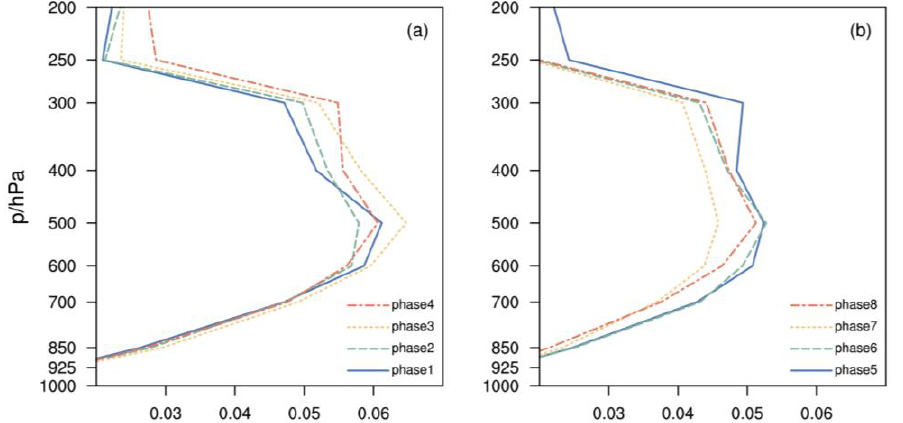
Figure 4. Vertical distribution of apparent heat source Q 1 (units: W/kg) in the ( a ) heating phase and ( b ) cooling phase in the Indo-China Peninsula (8° – 23° N, 93° – 108° E) during the first type of PHTEs.